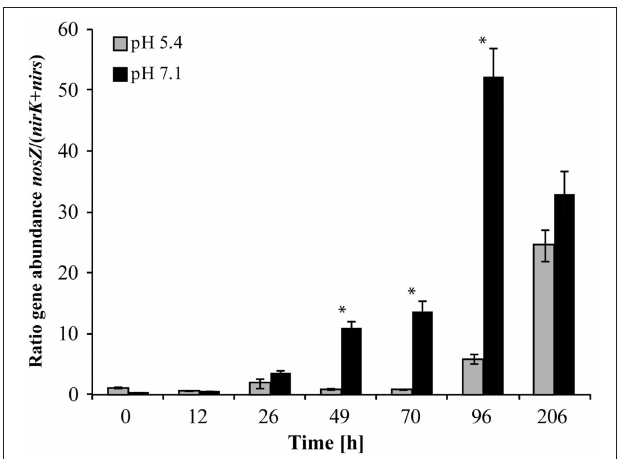
FIGURE 4 | Ratio of nosZ /( nirK + nirS ) gene copy numbers. An asterisk indicates significant differences in ratios between incubation at pH 5.4 and pH 7.1 at a given time point (ANOVA: P < 0.05 ). (Mean ± SD, n = 3 ).